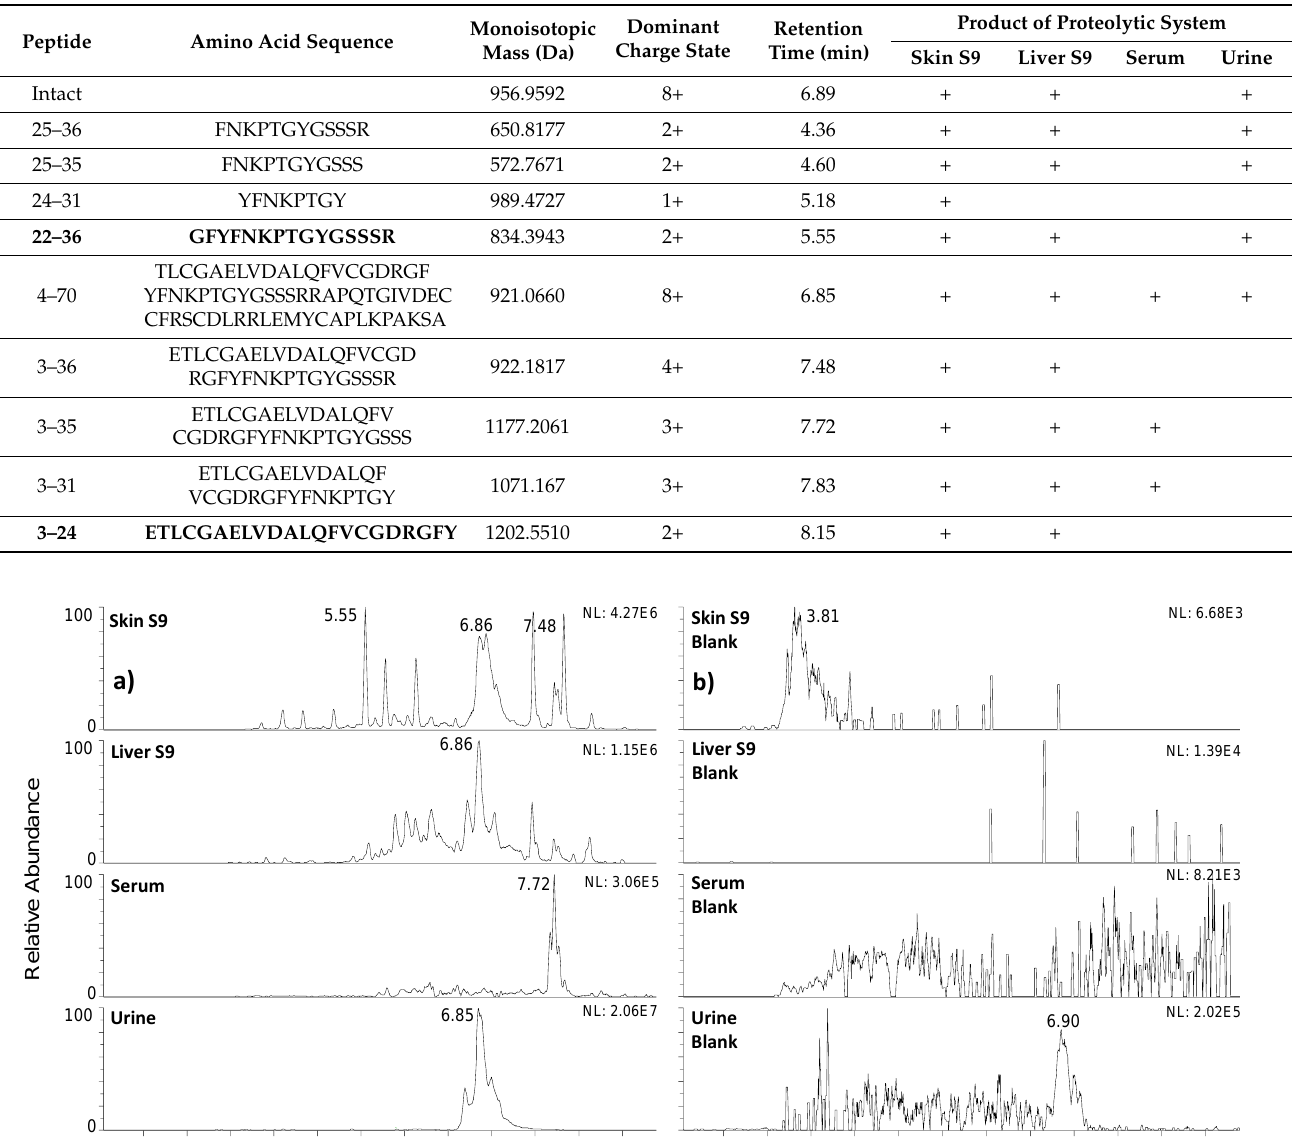
matograms after incubation of 15 N-IGF-I in all biological fluids examined, as well as their respective substrate blanks. This outlines the pronounced formation of metabolites in skin